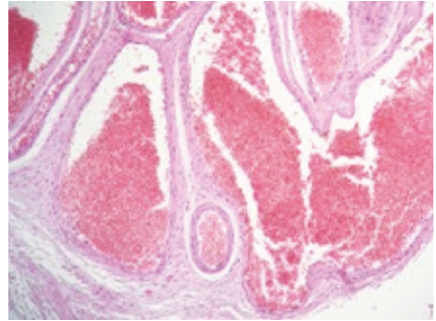
Figure 3: Regular flat endothelial cells bordering the vessels